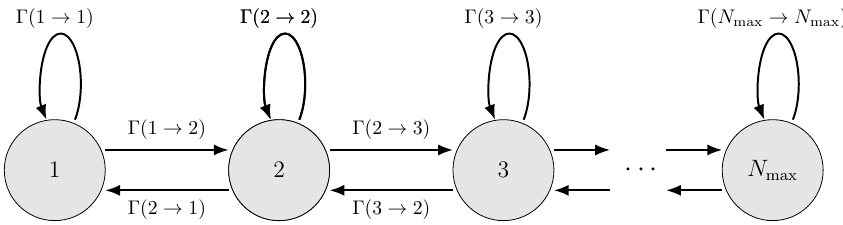
Figure 5: A network representation for model 1. Each node corresponds to a differ- ent value of the number of centers N and each (directed) edge is weighted by the probability to tunnel from one value of N to